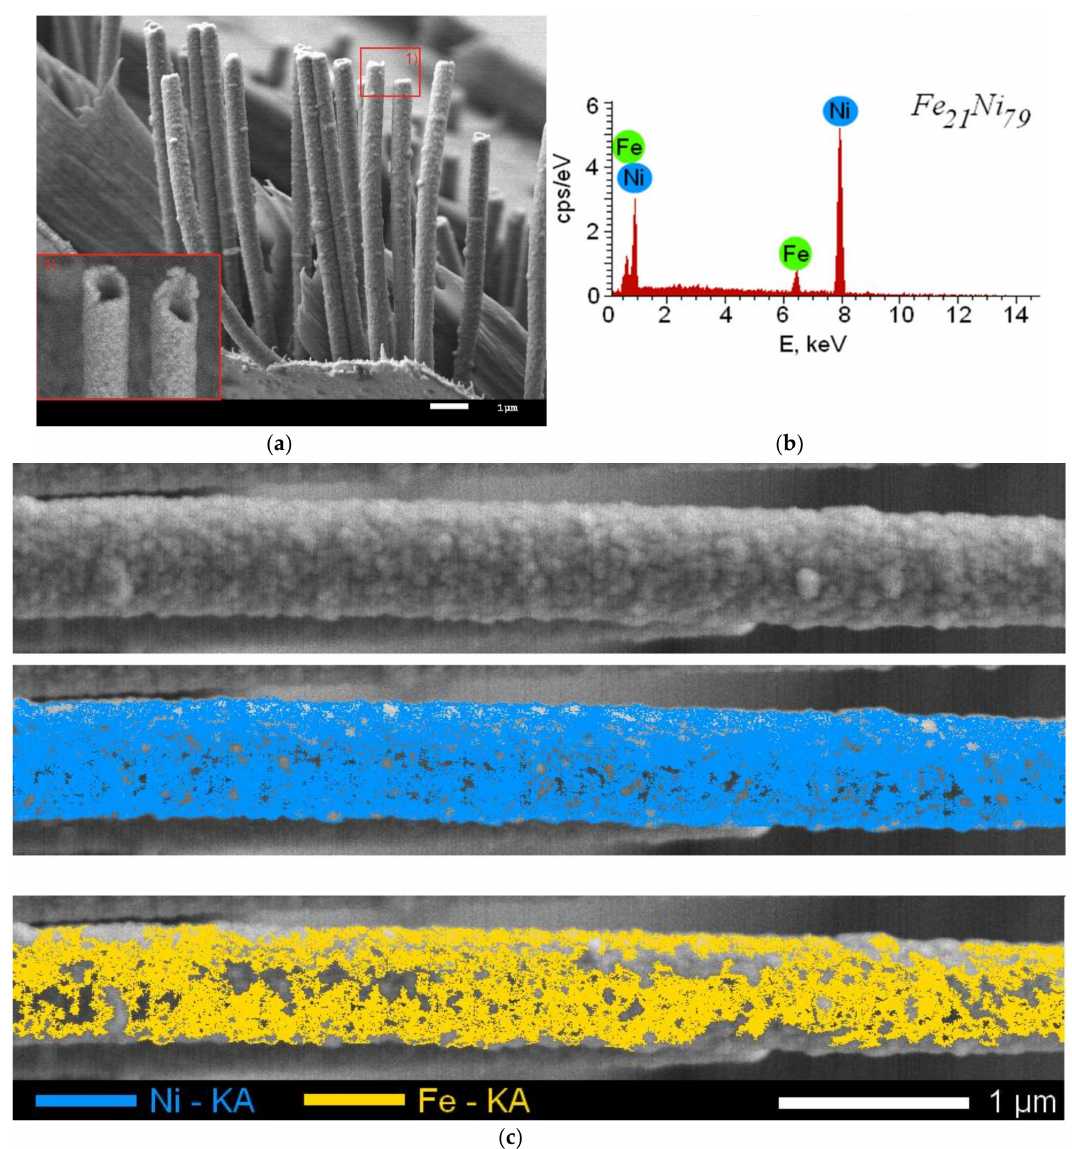
Figure 1. ( a ) SEM—image of arrays of nanostructures; ( b ) EDA spectrum of the studied nanostructures; ( c ) mapping results; results of changes in the morphology and elemental composition of